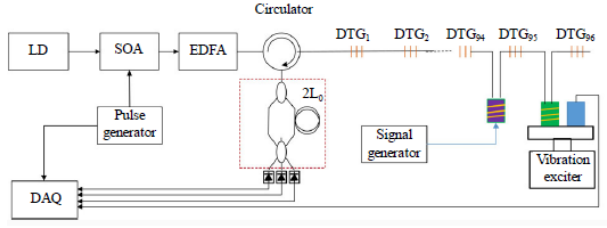
Fig. 3 Diagram of experimental